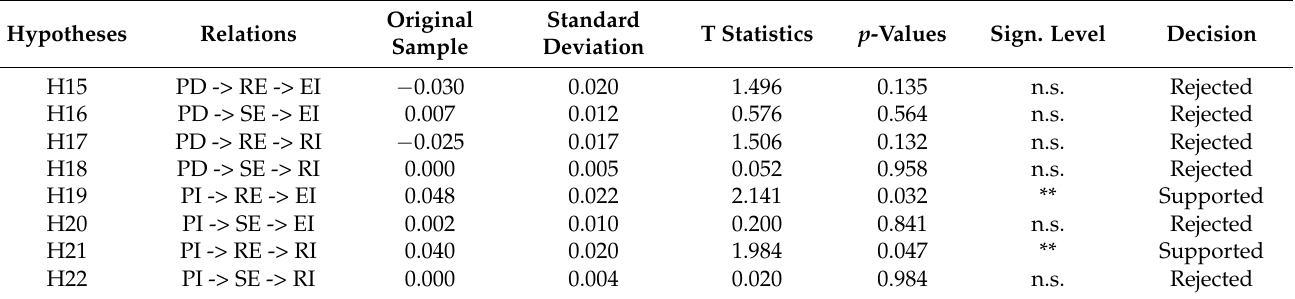
Table 6. Assessment of mediation